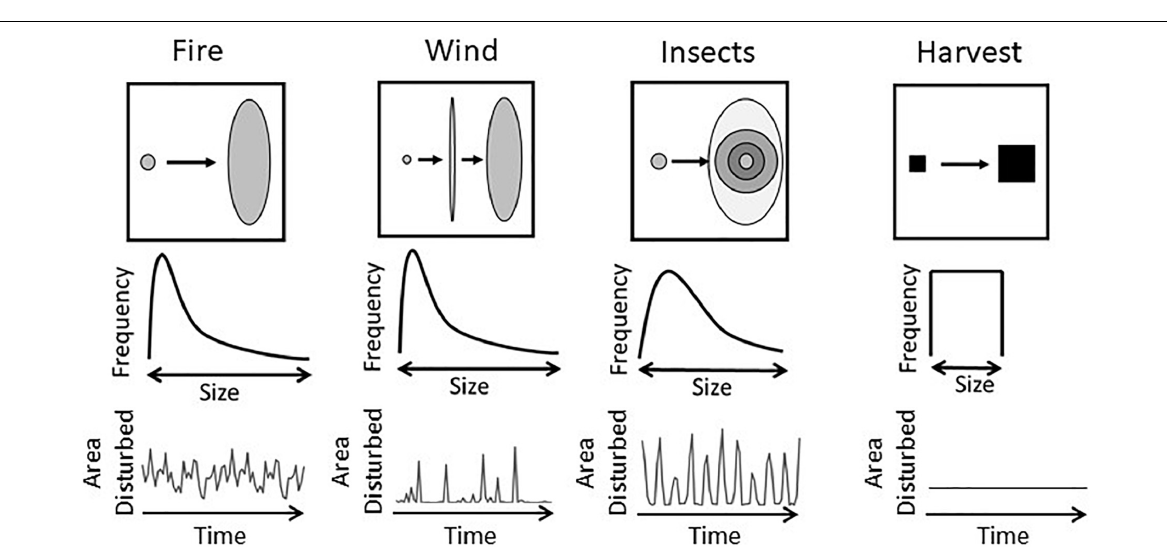
Frontiers in Ecology and Evolution |